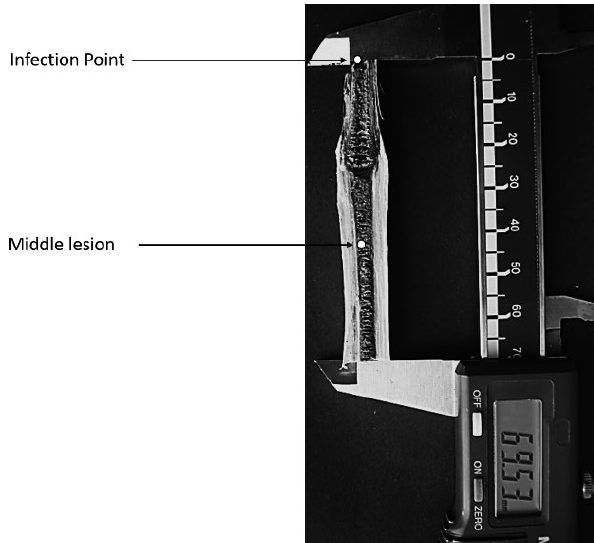
Figure 1. Details of infection assessment sampling from grapevine stems: white dots indicate inoculation points and middle lesion (ML) sampling position. Symptomless wood (SW) was removed 0.5 cm bellow the lesion end. Calliper reading shows lesion length (LL) in